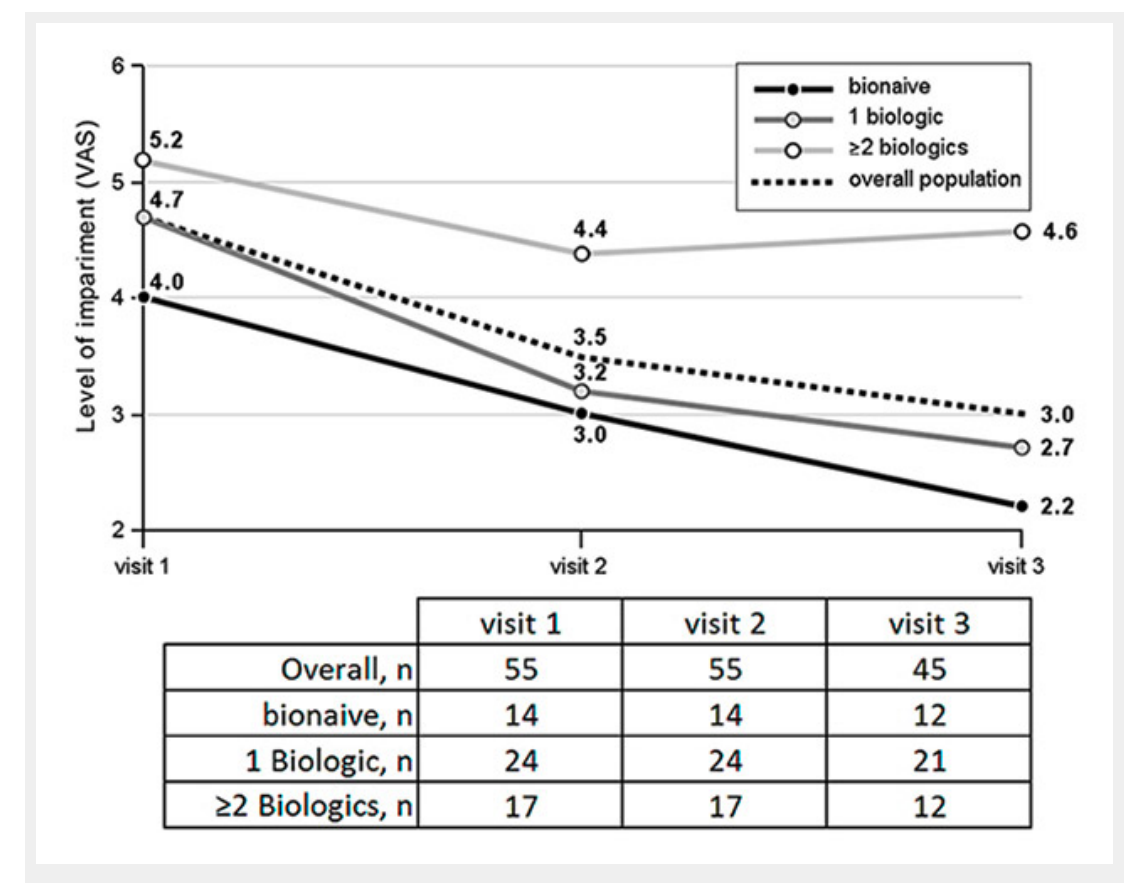
Figure 5 Impairment in daily activities: average level of patients’ impairment measured on a visual analogue scale (VAS): 1 = no impairment; 10 = severe impairment. The numbers of patients with available assessments at each visit are listed in the